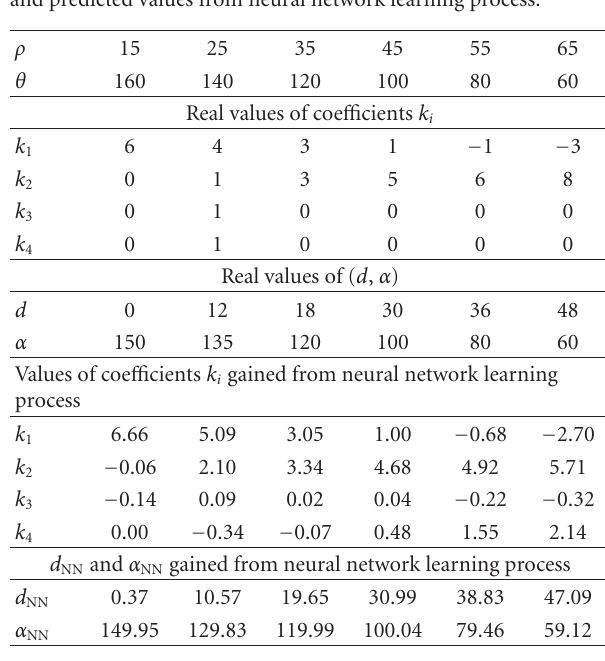
Table 4: Selected set of mobile robot positions from experiments and predicted values from neural network learning process.